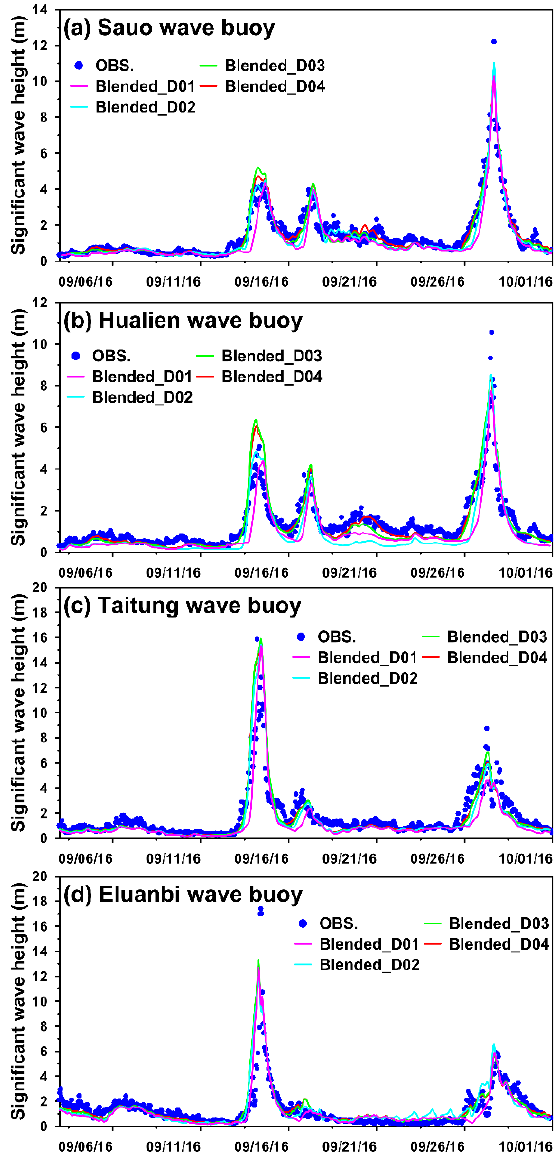
Figure 12. Comparison of the simulated and measured significant wave heights at the ( a ) Suao, ( b ) Hualien, ( c ) Taitung, and ( d ) Eluanbi wave buoys using the four computational domains and blended wind fields.